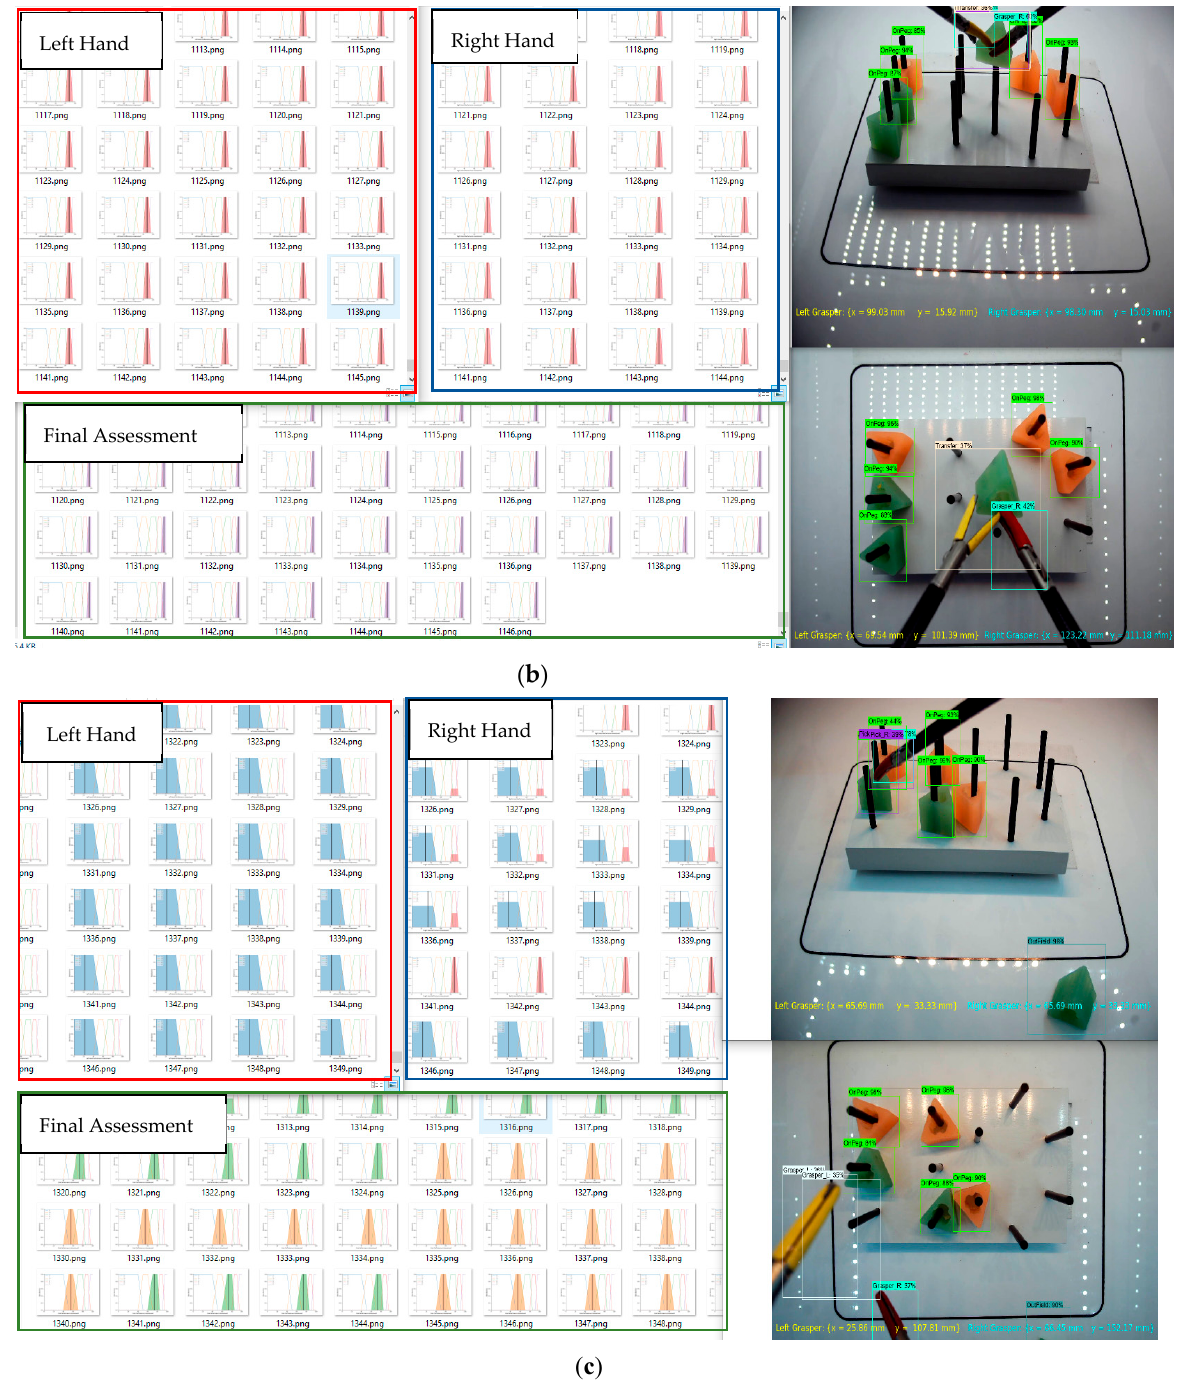
Figure 12. Object detection and measurement metric results by the top and front cameras, SLHPA, SRHPA, and final assessment FPA over a period of time.